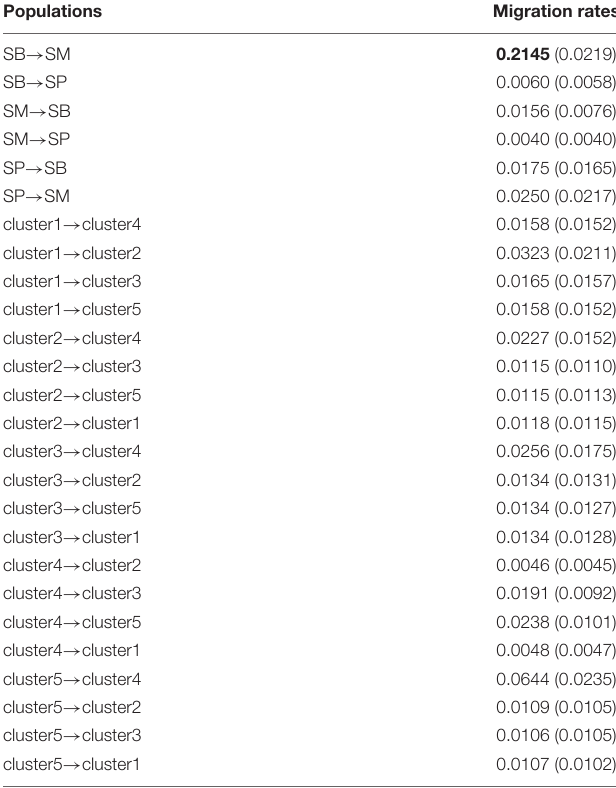
TABLE 3 | Posterior means of contemporary migration rates among species and TABLE 2 | Analysis of molecular variance (AMOVA) showing genetic variation genetic clusters estimated by BAYESASS (values in brackets are standard among and within three studied species from collection sites. deviations, and mean values more than 0.1 are considered Source of Sum Sq Variance % of P -value F-Statistics variation components variation